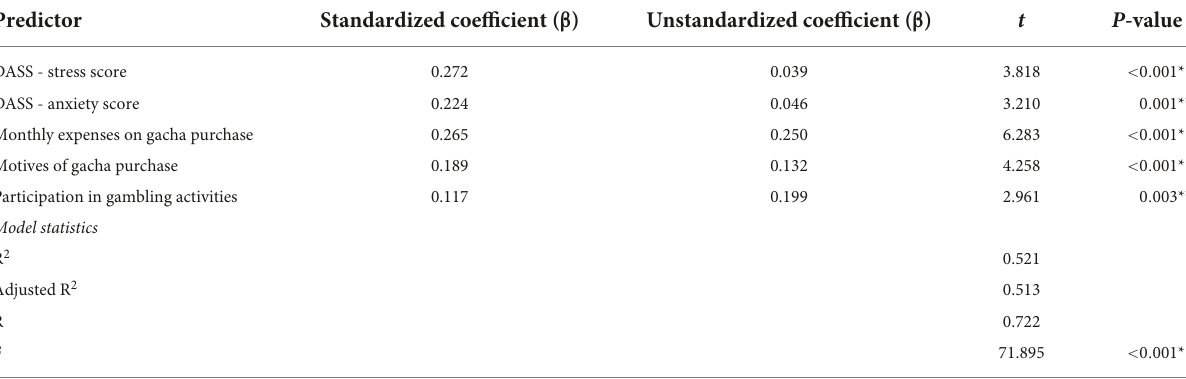
TABLE 4 Predictors of the total PGSI score modelled by stepwise multiple regression ( N